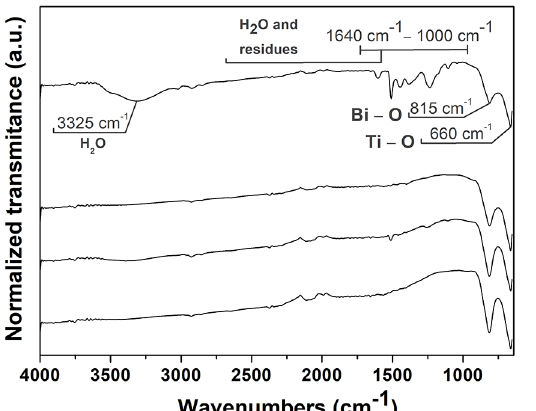
Figure 5. FTIR spectra of the synthesized samples